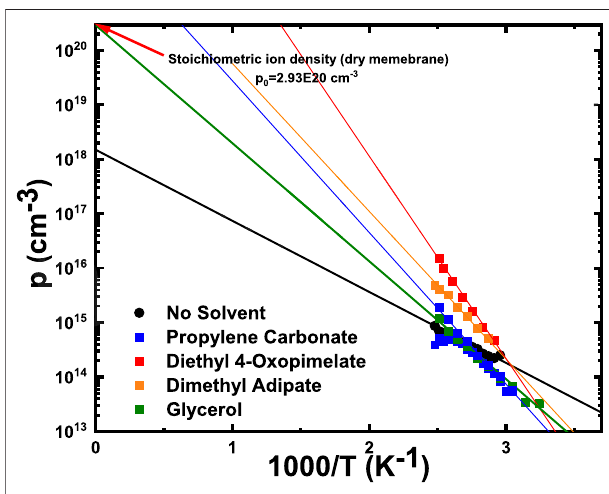
Frontiers in Energy Research |